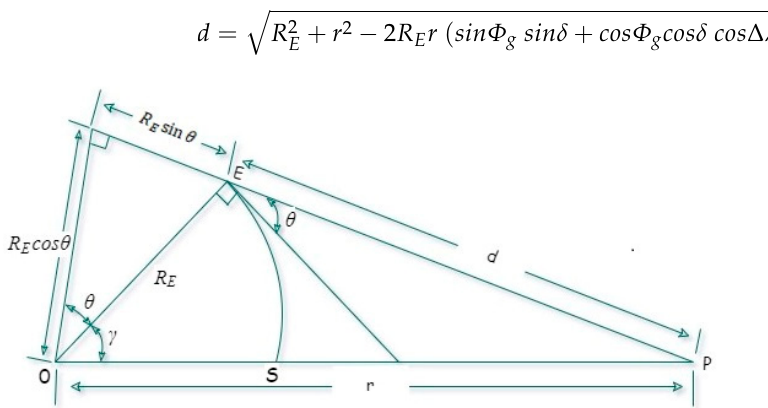
Slant range can be determined by applying cosine laws to the plane triangle using Equation (11), as shown in Figure 4.